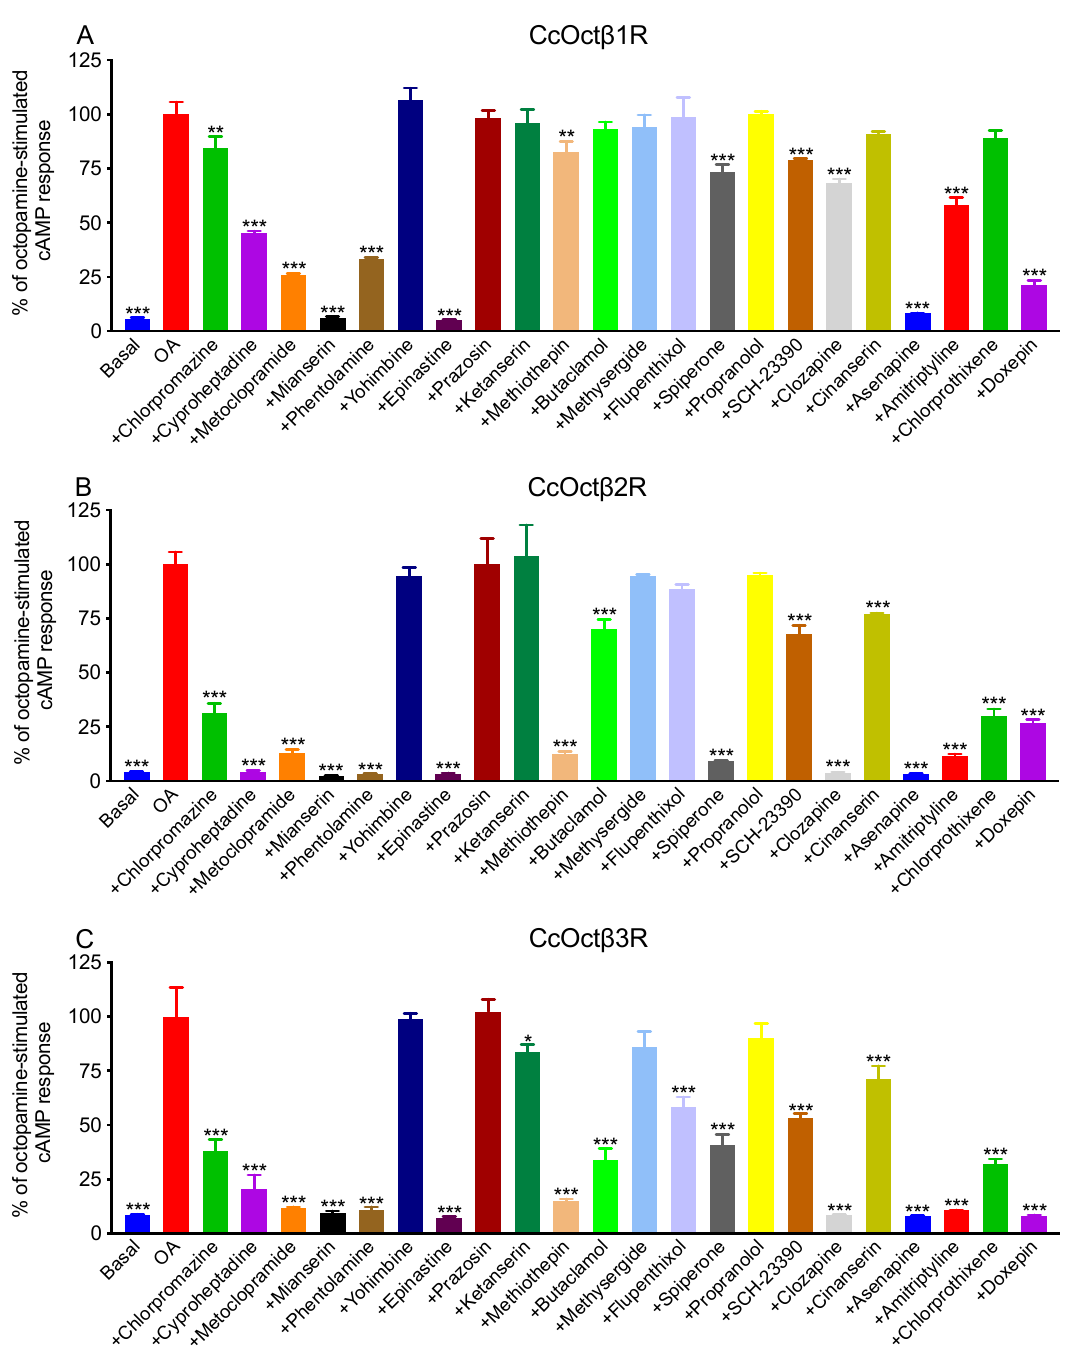
Figure 5. Effects of putative synthetic antagonists (10 μ M) on OA-stimulated intracellular cAMP production in CcOct β 1R ( A )-, CcOct β 2R ( B )-, and CcOct β 3R ( C )-expressing CHO-K1 cells. Dunnett’s multiple comparison test was performed for the statistical analysis (* p < 0.05, ** p < 0.01, *** p < 0.001).